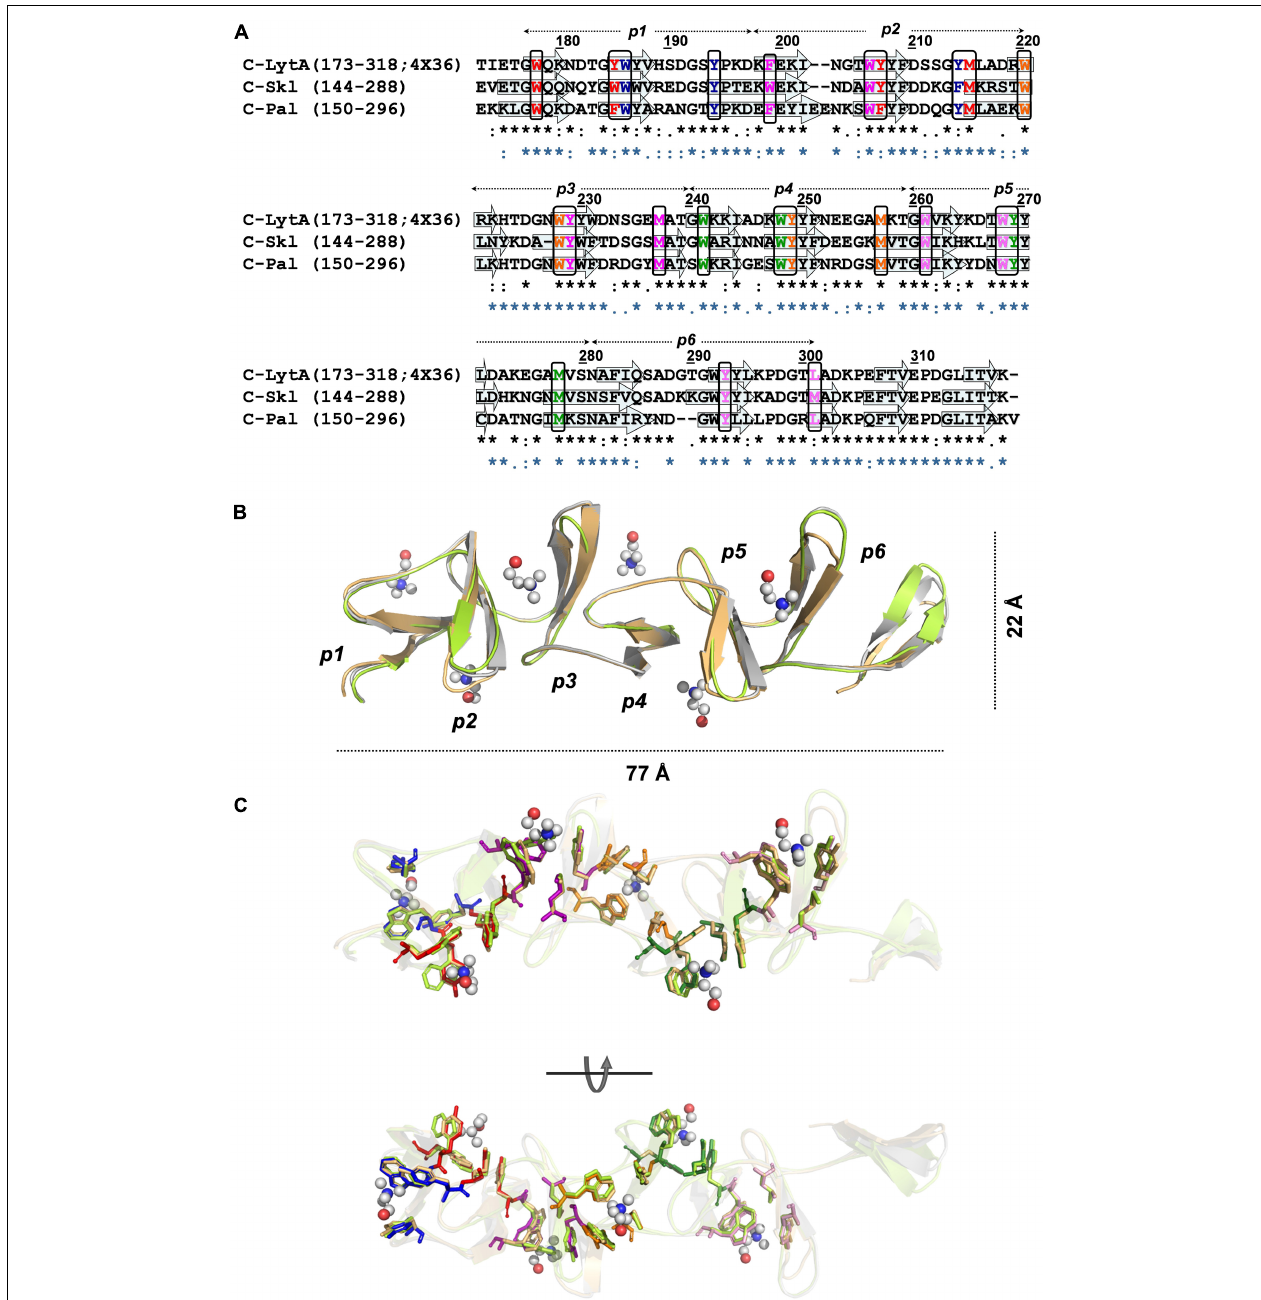
FIGURE 5 | Structural models of Skl and Pal CBDs. (A) Sequence alignment of C-Skl and C-Pal targets with 4X36 C-LytA template. Arrows indicate the positions of β -strands in C-LytA structure, and sequence-based predicted for targets. Black rectangles enclose residues involved in choline binding colored by site (1: blue, 2: red, 3: magenta, 4: orange, 5: green, 6: pink). Symbols at the bottom show sequence conservation of C-Skl (black) and C-Pal (blue) in relation to the template. (B) Structural superposition of final 3D models and the 4X36 template, in cartoon representation, colored in light green (C-Skl), light orange (C-Pal), and gray (C-LytA). (C) Structural conservation of residues involved in choline binding depicted in stick representation [color code: C-Skl (light green), C-Pal (light orange), and C-LytA (by site, as in (A) ). Choline molecules are depicted in the ball-and-stick model (C: gray, O: red, N: